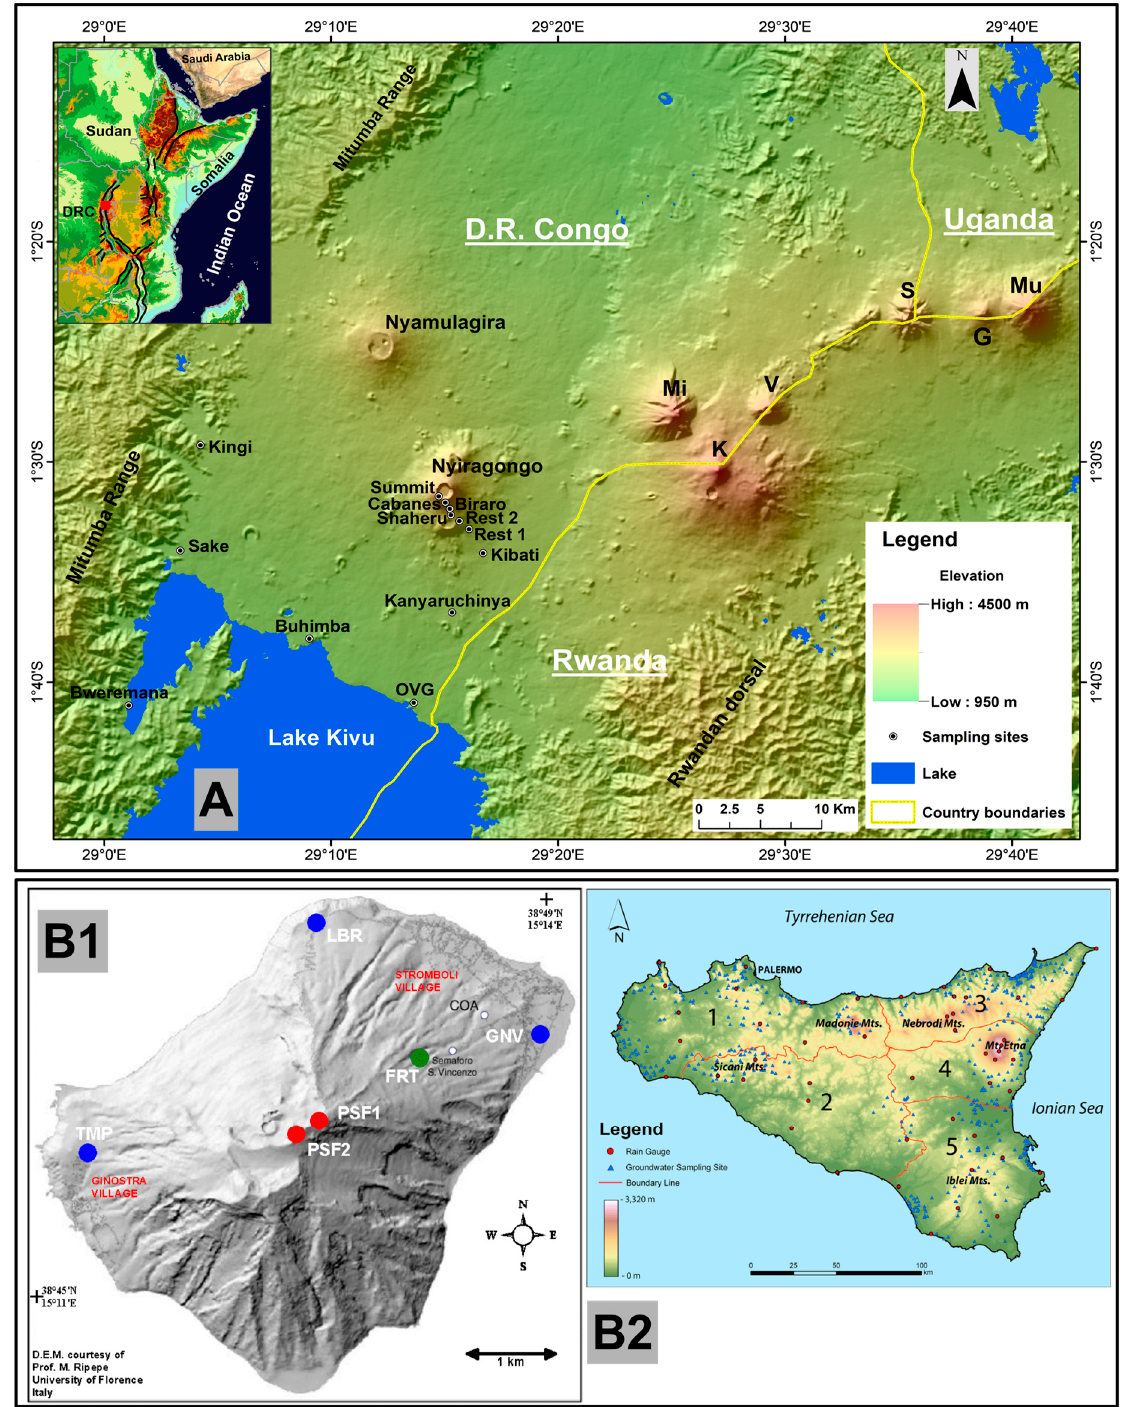
Figure 1. Topographic map of Virunga ( A ) located on the limit between Central and Eastern Africa, within the western branch of the East African Rift System (see insert map of A ); Stromboli ( B1 ) and Sicily ( B2 ) (Italy) in the Central Mediterranean. In Virunga, the sampling sites are situated in the north basin of Lake Kivu and on Mt Nyiragongo (3470 m a.s.l.). On the map ( A ), Mt Nyamulagira (3058 m a.s.l), Mt Mikeno (Mi, 4437 m a.s.l), Mt Karisimbi (K, 4508 m a.s.l), Mt Visoke (V, 3911 m a.s.l), Mt Sabinyo (S, 3647 m a.s.l), Mt Gahinga (G, 3474 m a.s.l), and Mt Muhabura (Mu, 4127 m a.s.l) are also shown. The sampling sites were designed in order to capture any spatial and altitudinal variations of the stable isotope composition of oxygen and deuterium in precipitation.